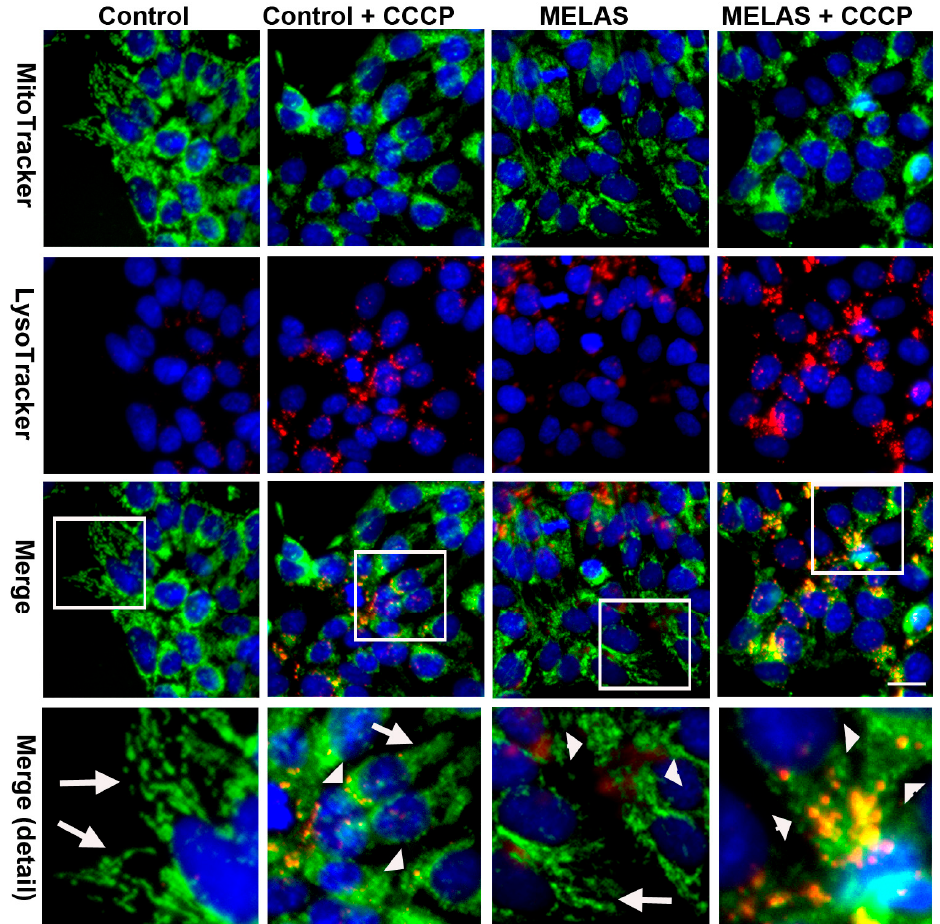
Figure 4. Activation of mitophagy in MELAS iPS cells. Microscopy fluorescence images showing levels of mitophagy after double staining with MitoTracker Green and LysoTracker Red in iPS cells in the presence or absence of CCCP. Colocolization fluorescence of MitoTracker Green and LysoTracker Red are indicative of mitophagy. The lower row shows magnification of the boxed area in the panel. Arrow indicates tubular mitochondria. Arrow head indicates fragmented mitochondria. Scale bar: 20 μ m.